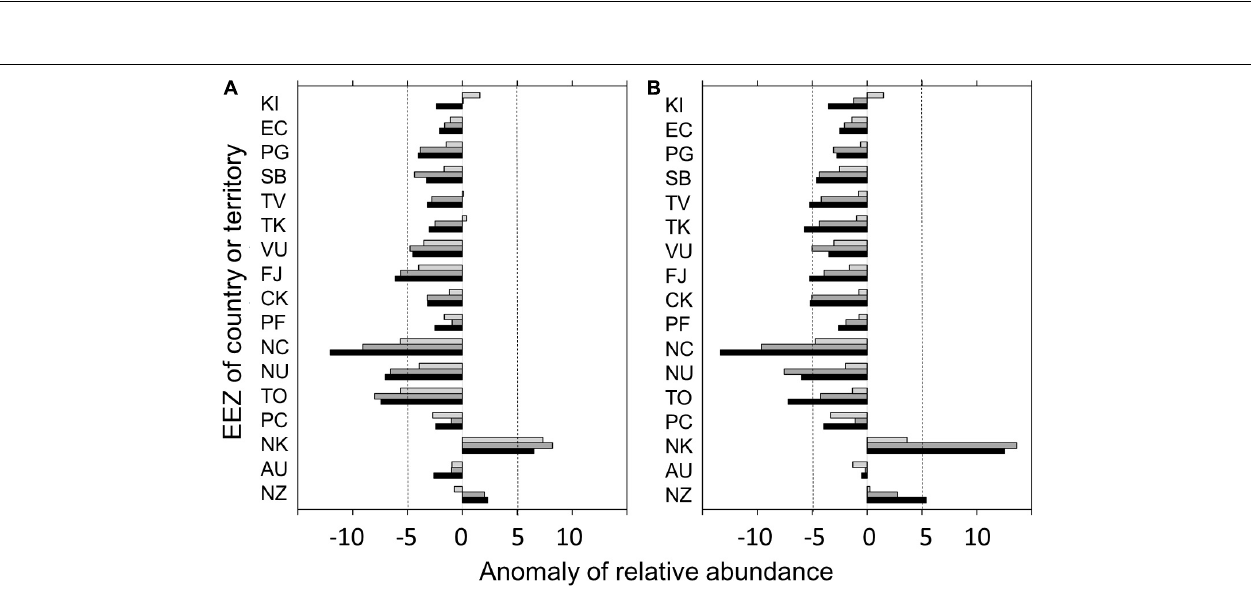
FIGURE 6 | Changes in albacore relative abundance (number/1,000 hooks) within the exclusive economic zones (EEZs) of the countries or territories in the south Pacific Ocean for the current (2020), mid (2050), and late (2080) periods of the twenty-first century relative to 2012–2016 under the (A) RCP 4.5 and (B) RCP 8.5 scenarios. Only those countries or territories that had more than 30% of fishery data inside their EEZs were analyzed in this study. Countries or territories were ordered per mean latitude of the EEZ. The vertical dashed lines denote the reference line of ± 5 in anomaly of relative abundance. Country codes not shown in Supplementary Table 1 were illustrated below. EC, Galapagos Islands; TK, Tokelau; NU, Niue; PC, Pitcairn; NK, Norfolk Island.